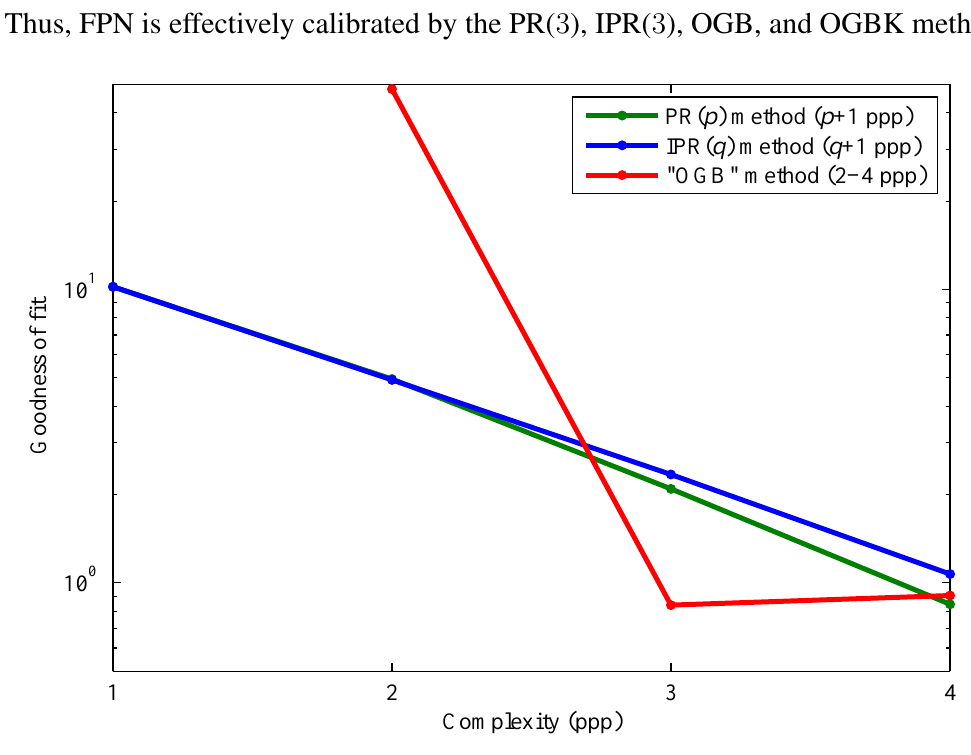
Figure 4. Comparison of FPN calibration methods. The overall goodness of fit is the ratio of overall RMS residual FPN to overall RMS temporal noise. This paper introduced the polynomial regression (PR) and inverse polynomial regression (IPR) methods, whereas the offset-gain-bias (OGB) and related methods are taken from the